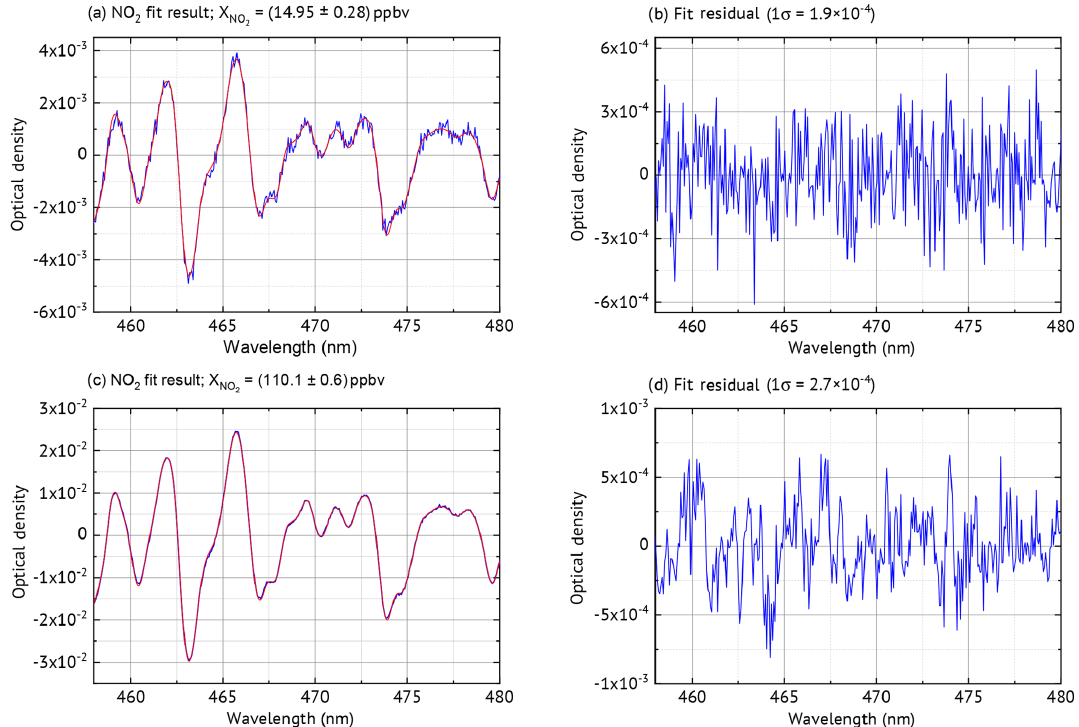
Figure 10. Exemplary ICAD (configuration 1) fit results for gas mixtures of ( 15 . 0 ± 0 . 3 ) ppbv (a) , (b) and ( 110 . 1 ± 0 . 6 ) ppbv (c) , (d) . Panels on the left side show the measured optical density (blue) and the fitted NO 2 cross section. Panels on the right side show the corresponding fit residuals.